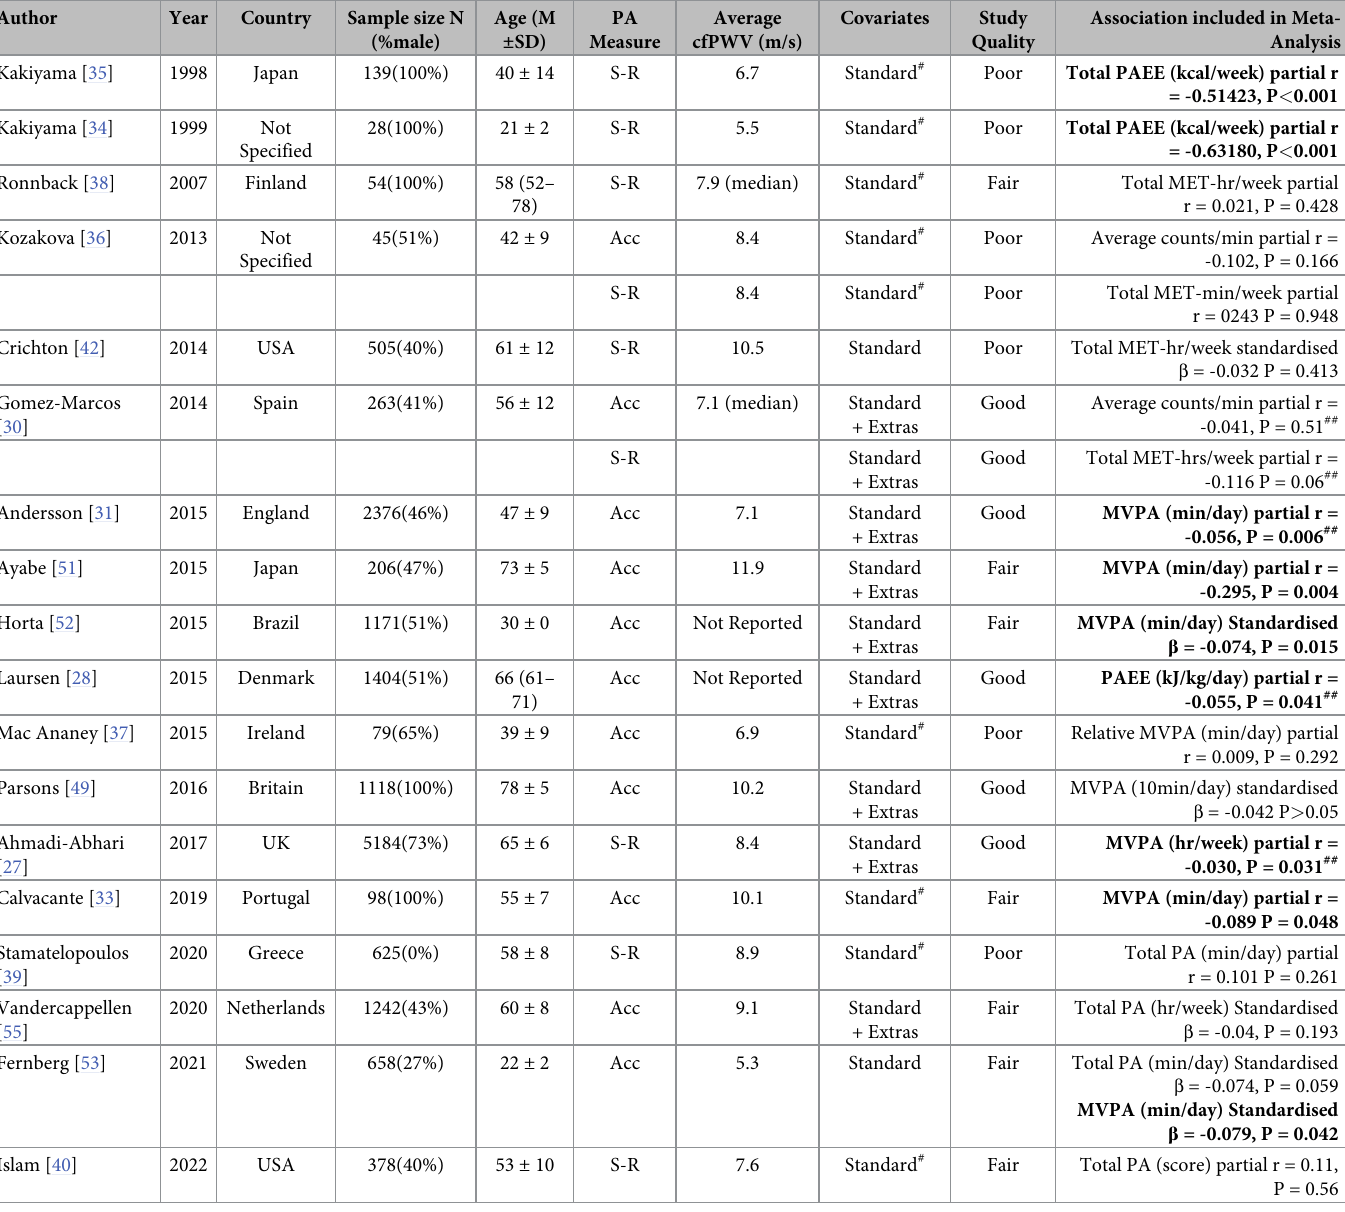
Table 1. Summary of 18 studies included in pooled